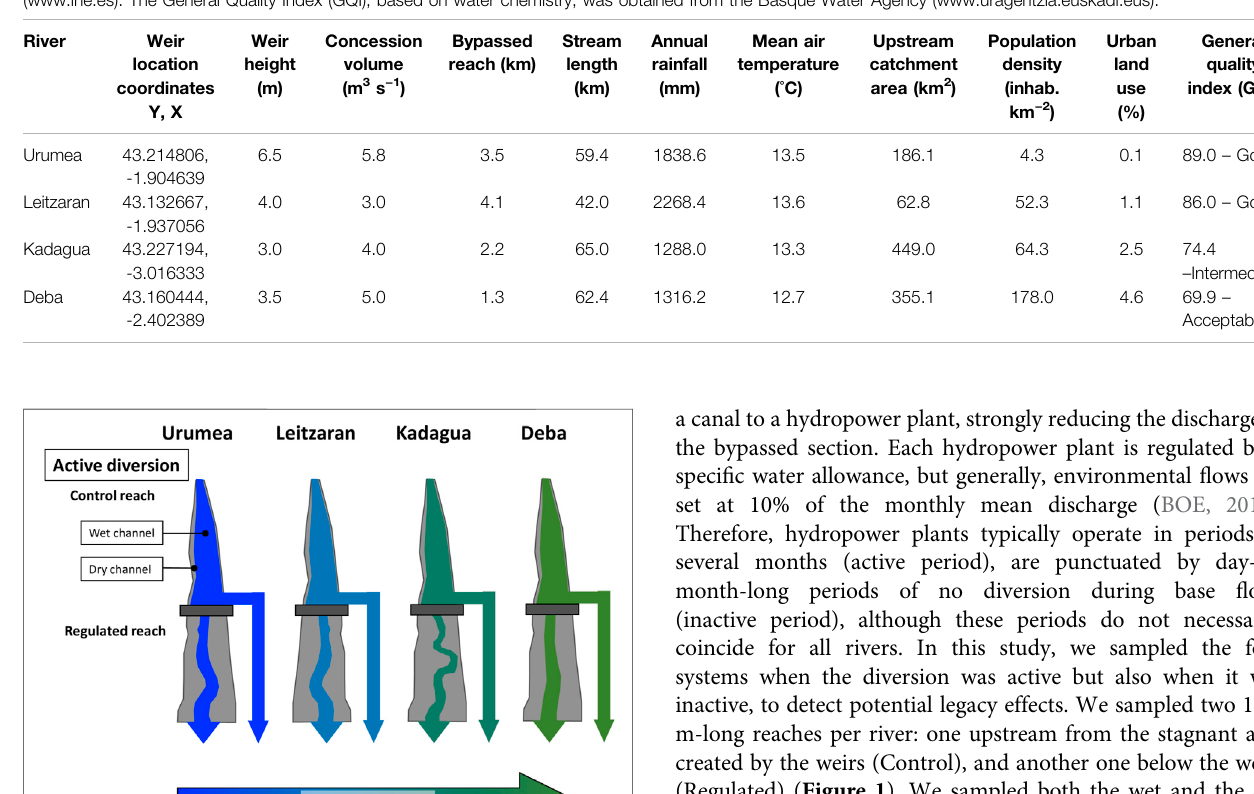
TABLE 1 | Main characteristics of the studied rivers and the water diversion schemes within. The total annual rainfall and mean annual air temperature are the average ofthe 2 years of the study (www.euskalmet.euskadi.eus). Weir height, concession volume, and bypassed reach were obtained from the Cantabrian Hydrographic Confederation and the Institute of the Cultural Heritage of Spain (CHC, 2013; Pérez-Marrero, 2017). Population density was obtained from the National Statistics Institute (www.ine.es). The General Quality Index (GQI), based on water chemistry, was obtained from the Basque Water Agency (www.uragentzia.euskadi.eus).